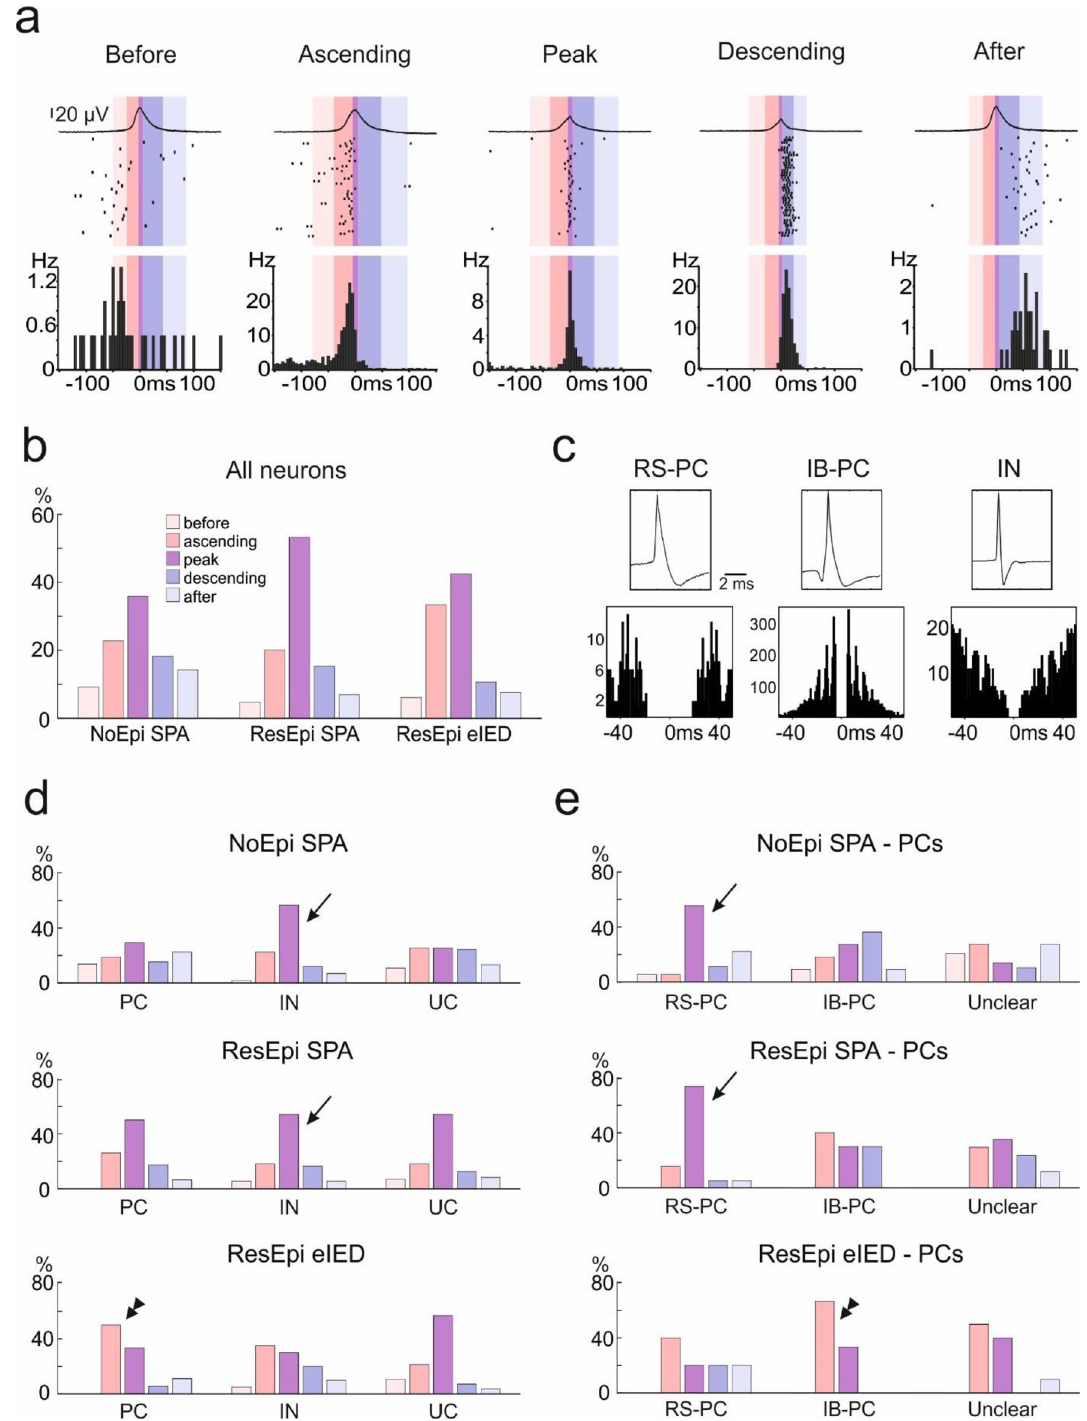
Figure 4. Relative firing change during SPAs and eIEDs. The firing change of neurons was examined during the different phases of SPA/eIED. ( a ) Examples of cells with increased firing during before, ascending, peak, descending and after phases of synchronous events. The upper trace shows the average LFPg of the respective SPA, the raster plot displays randomly chosen sweeps of the cell, and the peri event time histogram (bottom) averages the firing of the cell. Coloured areas mark the different phases of the event (for colour coding see inset in ( b )). ( b ) Percentages of cells with increased firing rates during the different phases of SPAs/eIEDs. Note the high proportion of ‘ascending’ cells during eIEDs. ( c ) Regular spiking (RS-PC) and intrinsically bursting (IB-PC) PCs, as well as INs were identified based on the waveform of their APs (upper panel) and their autocorrelogram (lower panel). ( d, e ) High numbers of interneurons (arrows on ( d )) and regular spiking PCs (arrows on ( e )) increased their firing rate during the peak phase of SPAs (both NoEpi and ResEpi, upper and middle panels, respectively), while PCs (double arrowhead on ( d )), especially intrinsically bursting PCs (double arrowhead on ( e )) preferred to elevate their firing rate during the ascending phase of eIEDs (lower